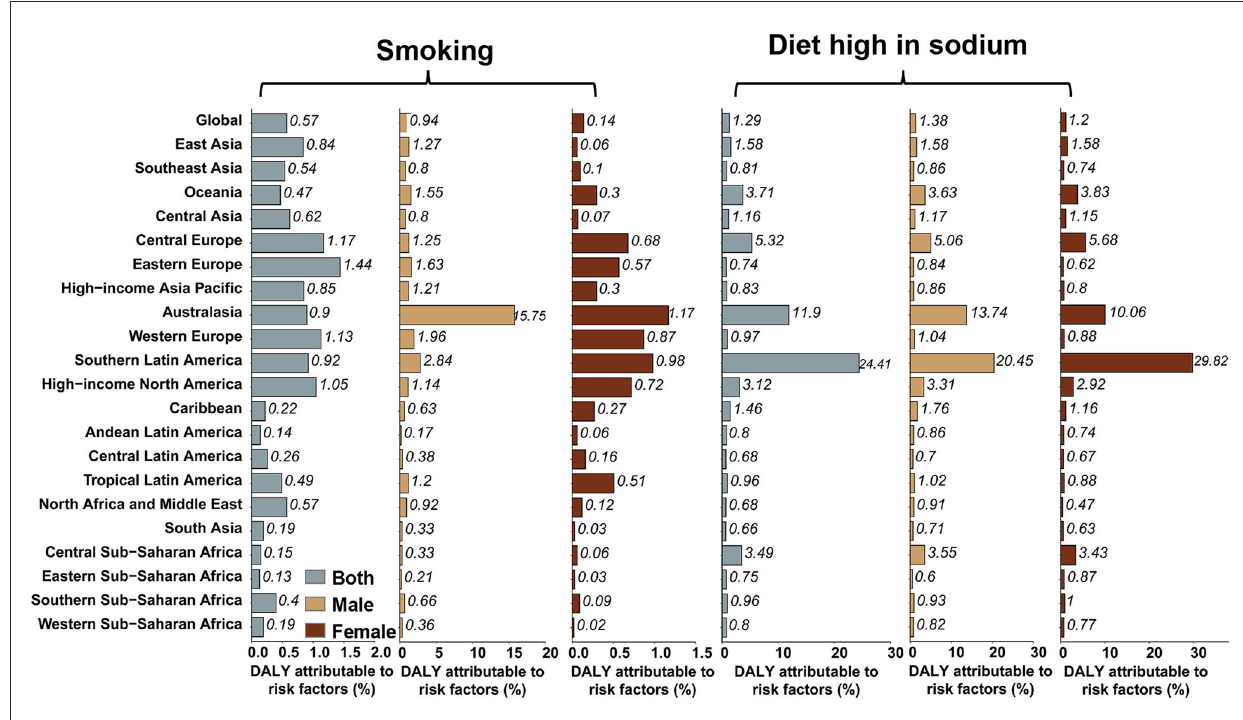
FIGURE6 Percentage of stomach cancer age-standardized DALYs attributable to high-sodium diet and smoking in 2019, globally, and for 21 GBD